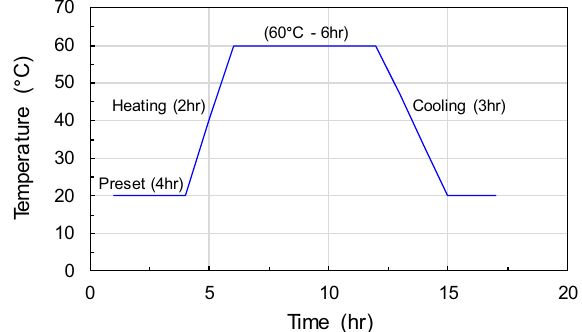
Fig. 1 Temperature history for steam curing.